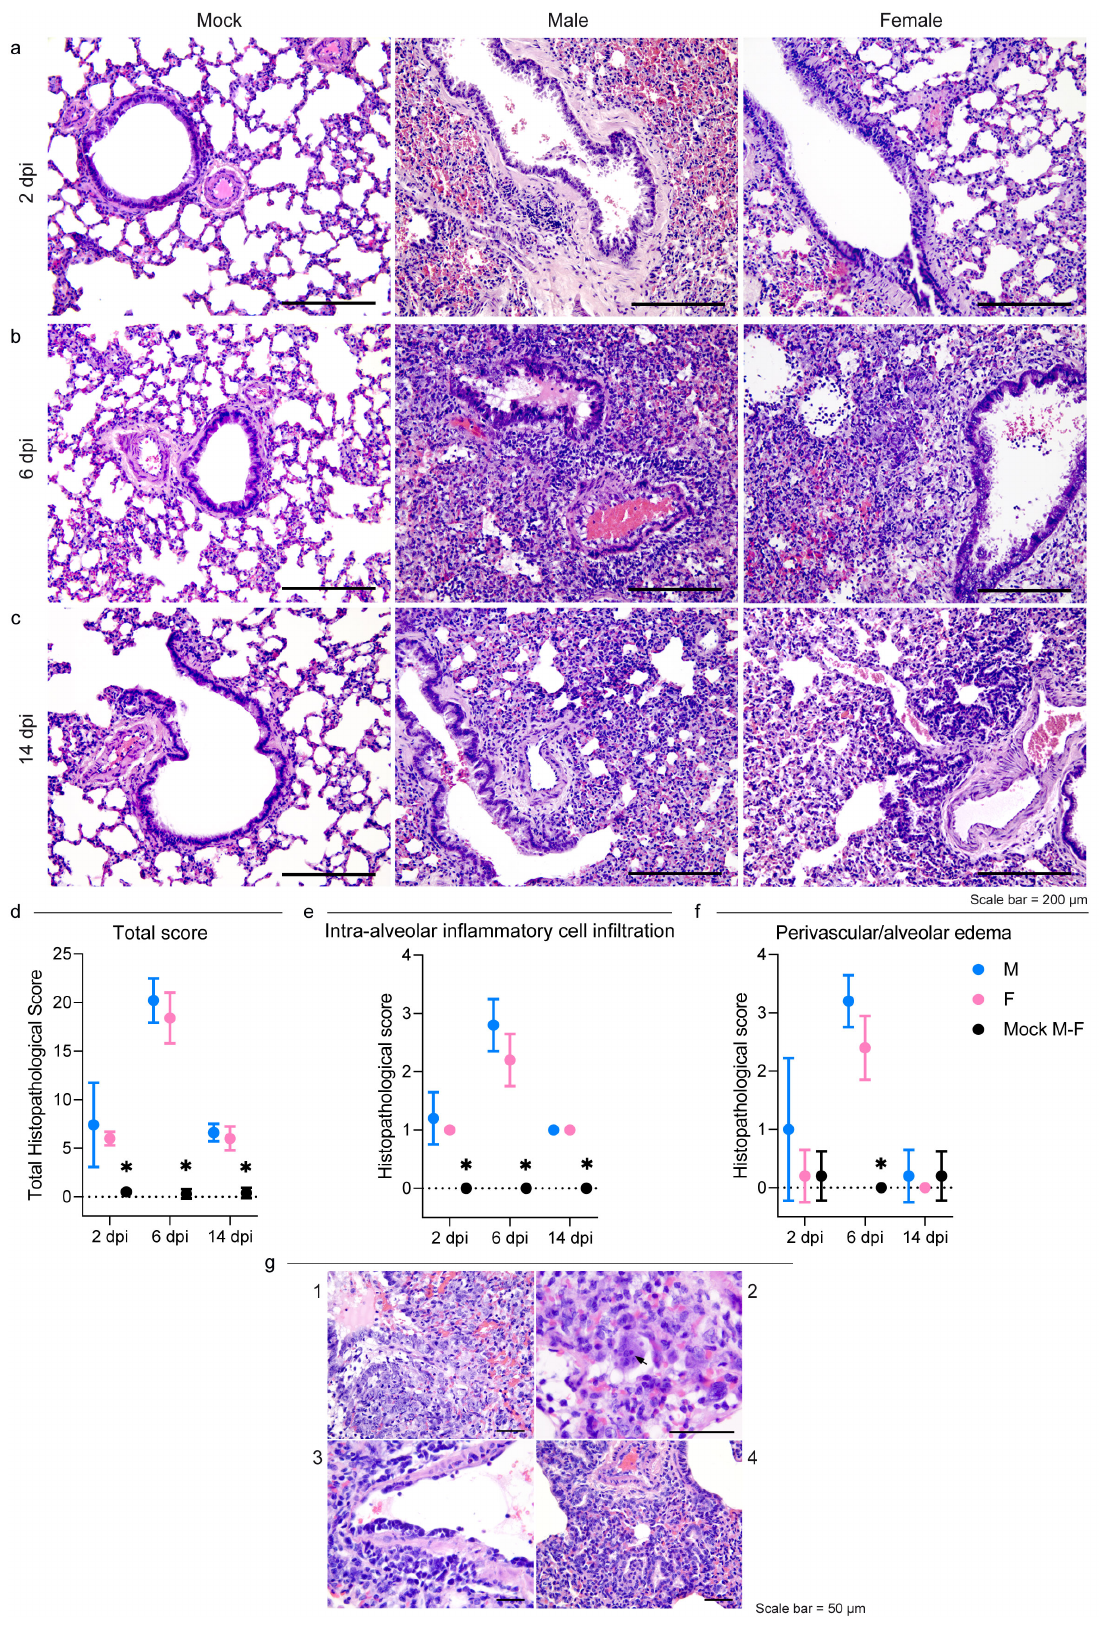
Figure 2. SARS-CoV-2 infection results in severe but rapidly resolving pulmonary lesions in male and female Syrian hamsters. ( a – c ) Representative images of Syrian hamster lungs collected at 2, 6, and 14 dpi and those of mock animals. The images show H&E-stained sections. Scale bar = 200 µm. All animals were analyzed; representative images are shown. ( d ) Cumulative score of lung pathol- ogy for nine histopathological assessments in male and female hamsters (Table S2); mean values ± SD are represented. Wilcoxon–Mann–Whitney test for males vs. females: 2 dpi p = 0.86; 6 dpi p = 0.31; 14 dpi p = 0.72 . ( e – f ) Histopathological scores of intra-alveolar inflammatory cell infiltration ( e ) and perivascular/alveolar edema ( f ) in male and female hamsters (Table S2; all animals were ana- lyzed). Mean values ± SD are represented. Wilcoxon–Mann–Whitney test of mock animals vs. fe- males of total histopathological score (2 dpi p = 0.0007; 6 dpi p = 0.0003; 14 dpi p = 0.0003), intra-